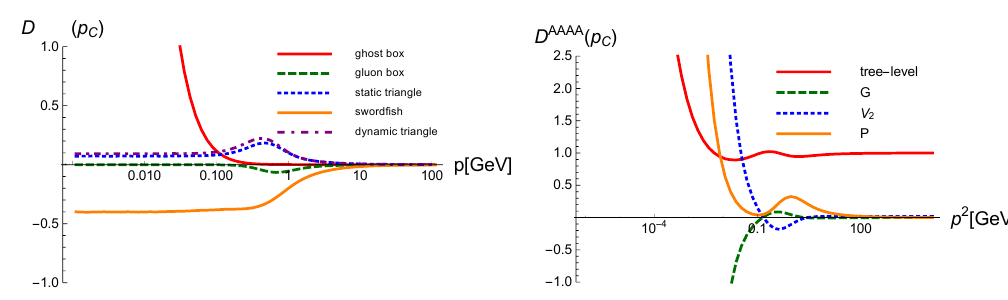
Figure 4. Left: Contributions of single diagrams to the four-gluon vertex. Right: Results for various dressings of the four-gluon vertex.